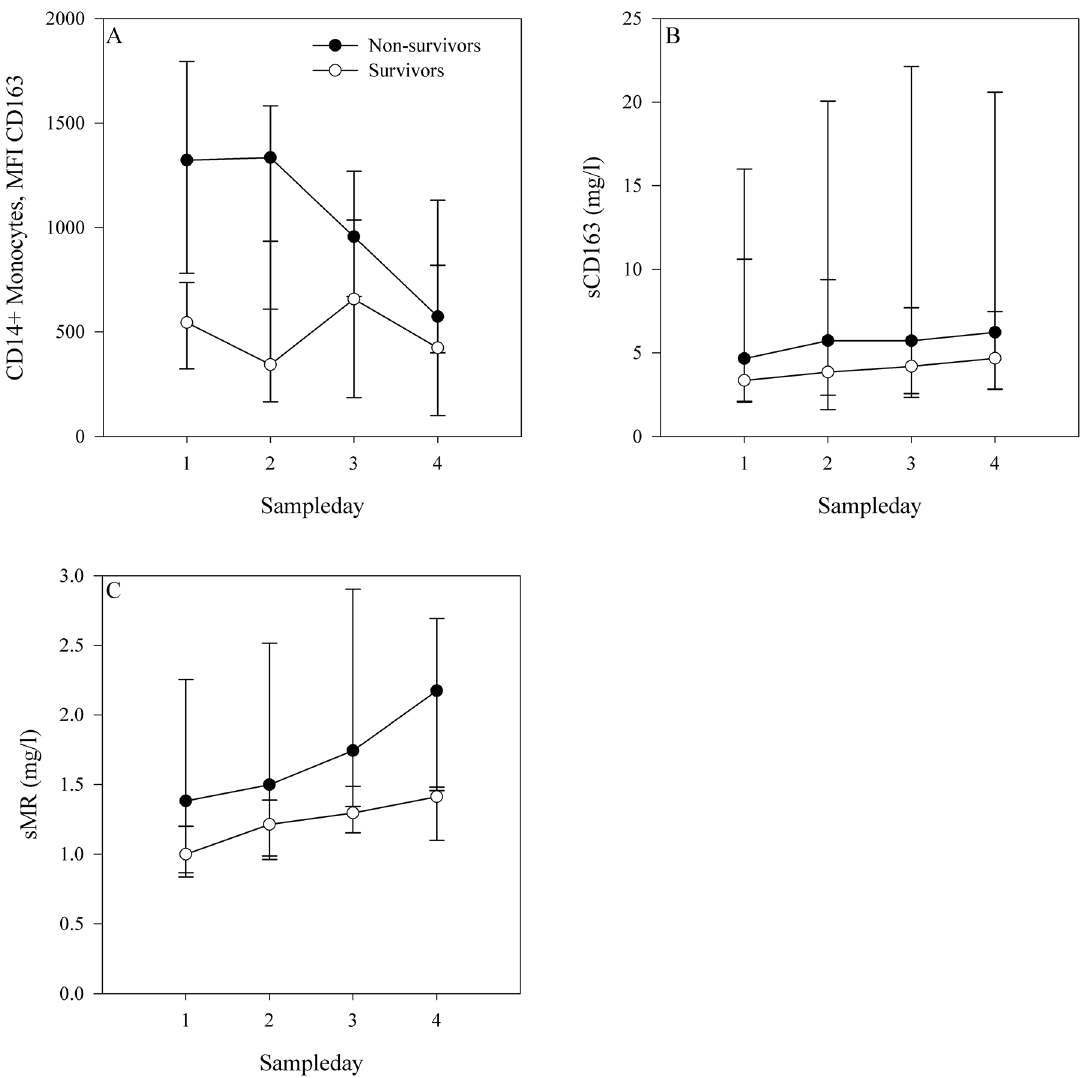
Figure 3. Levels of sCD163, sMR and the expression of monocyte-bound CD163 in in-hospital survivors and non-survivors within the septic group during the four-day observation period. A: Monocyte expression of CD163 was higher in non-survivors compared with survivors, both at ICU admission and during the four-day observation period. B + C: There were no difference in the levels of sCD163 (Panel B) or sMR (Panel C) between survivors and non-survivors, neither at ICU admission nor during the observation period. The x-axis represents time and the y-axis represents the expression or level of each potential biomarker. Dots represent the median, bars represent the interquartile range. doi:10.1371/journal.pone.0092331.g003 may indicate infectious inflammation in sepsis better than the non- specific CRP [15].